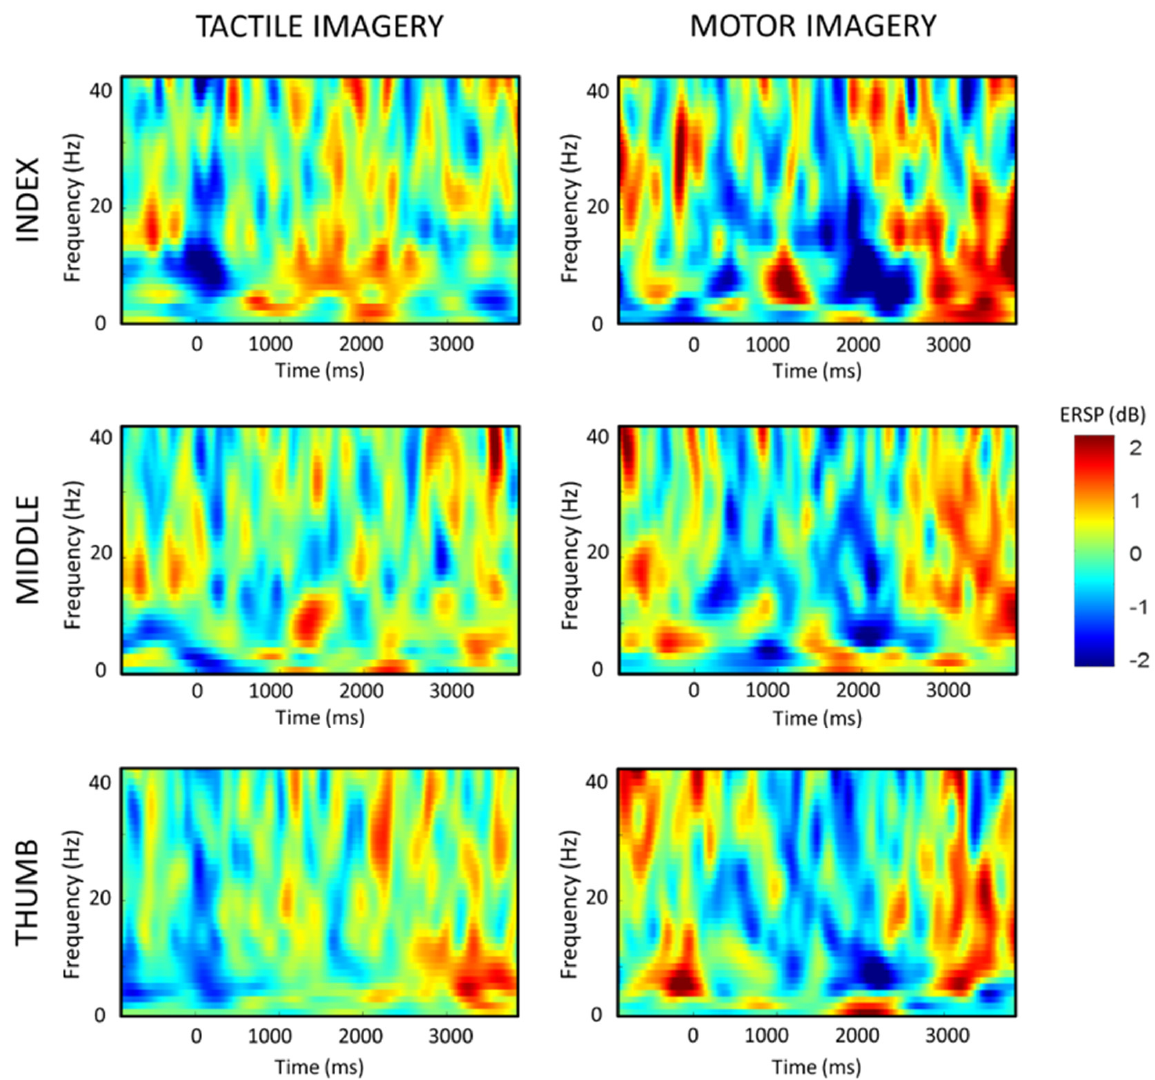
Figure 2. Averaged time–frequency maps of all participants. Blue indicates ERD.